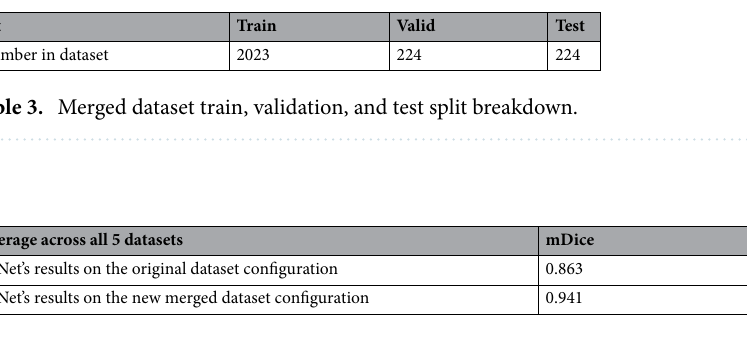
Table 4. Comparative results of PSNet against old training procedure with original dataset configuration with the new training procedure with the modified merged dataset configuration.